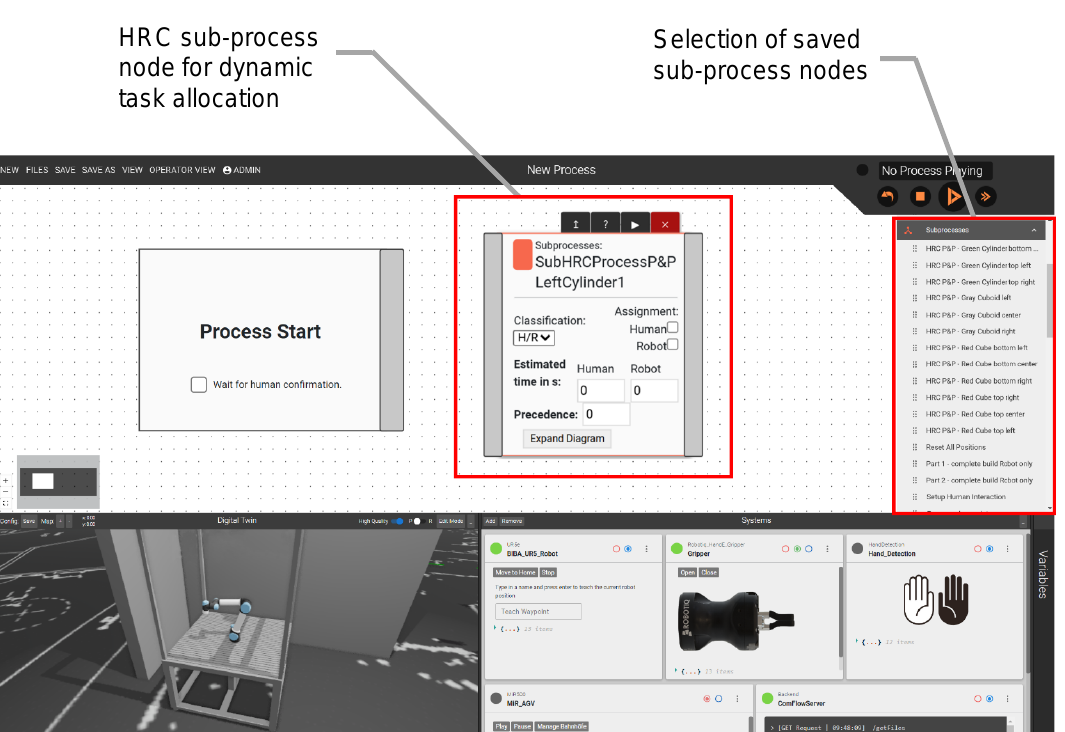
Figure 9. Implementation of sub-processes and HRC nodes in user interface: Selection of the saved HRC sub-process for the creation of the overall assembly process.